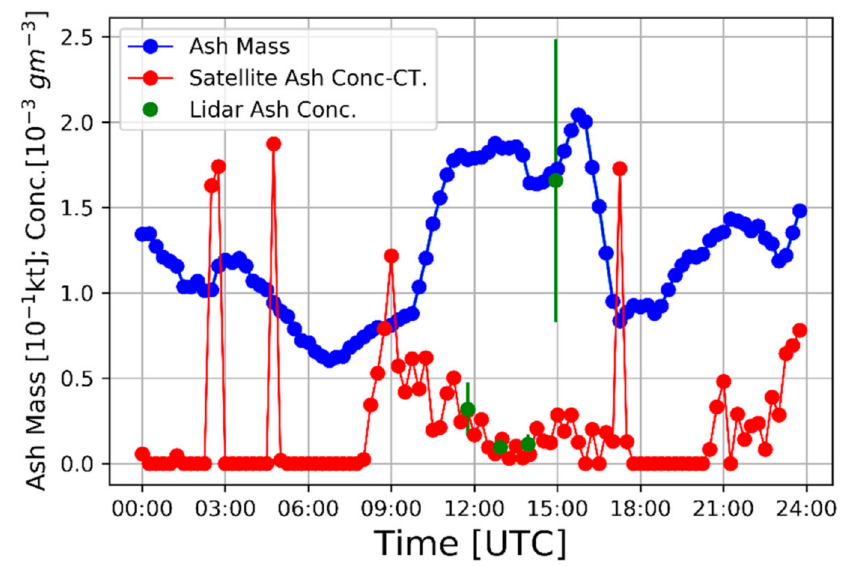
Figure 9. Total ash mass detected by satellite, volcanic ash mass concentration evaluated by satellite in a single pixel placed above the AMPLE Lidar station in Catania, 25 km from the source (Satellite Ash Conc.-CT) and compared with the mean values of volcanic ash concentration obtained by Lidar (Lidar Ash